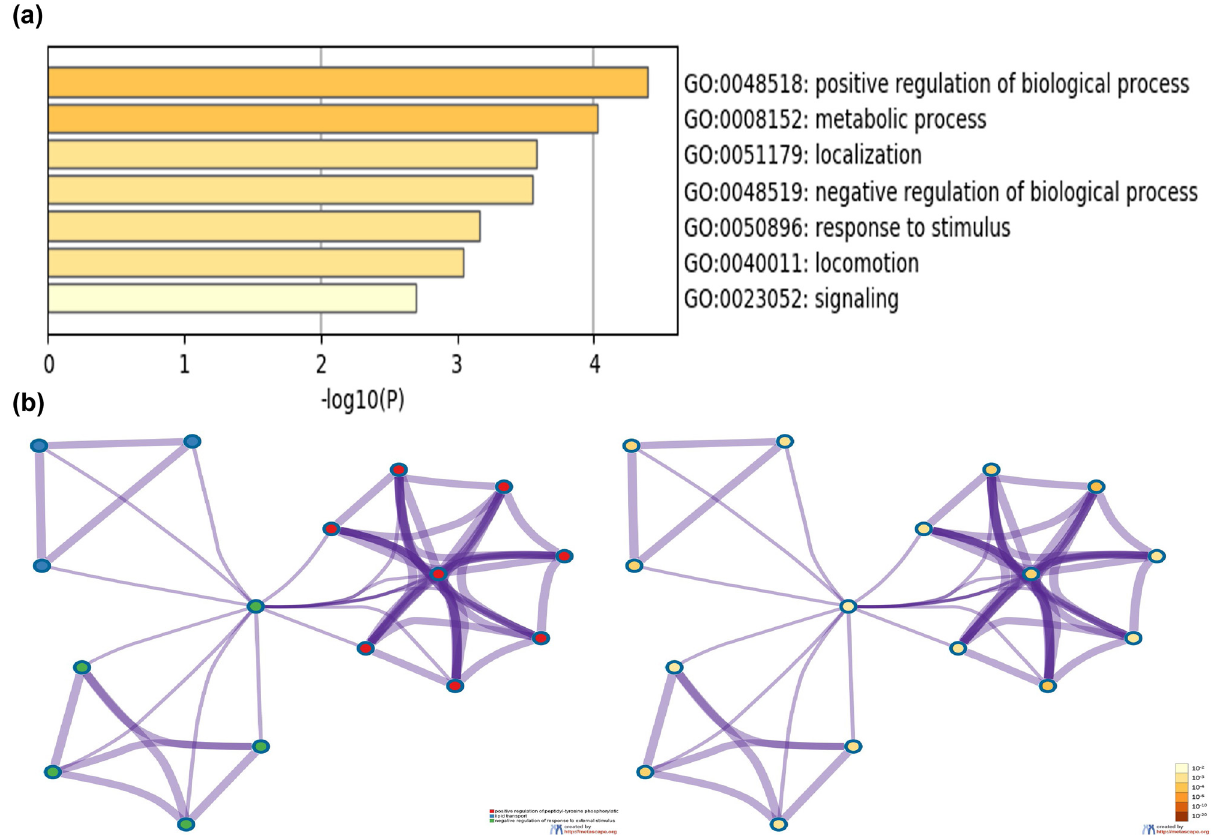
Figure 6: Functional and pathway enrichment analyses of the signature of nine immune - relevant genes. ( a ) GO terms and KEGG pathway are presented, and each band represents one enriched term or pathway colored according to the − log 10 ( P ) . ( b ) Network of the enriched terms and pathways. Nodes represent enriched terms or pathways, with node size indicating the number of genes of the immune gene signature involved in. Nodes sharing the same cluster are typically close to each other, and the thicker the edge